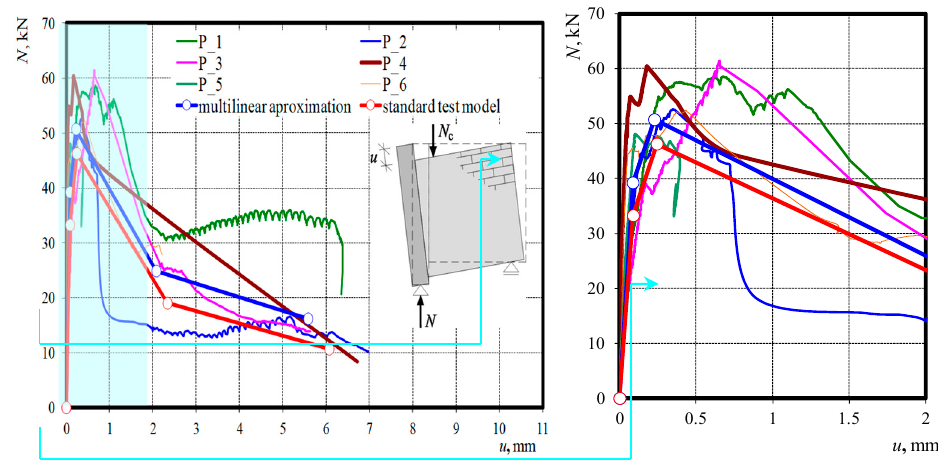
Figure 5. Relationship between the total force and mean displacement for test results and calculations.